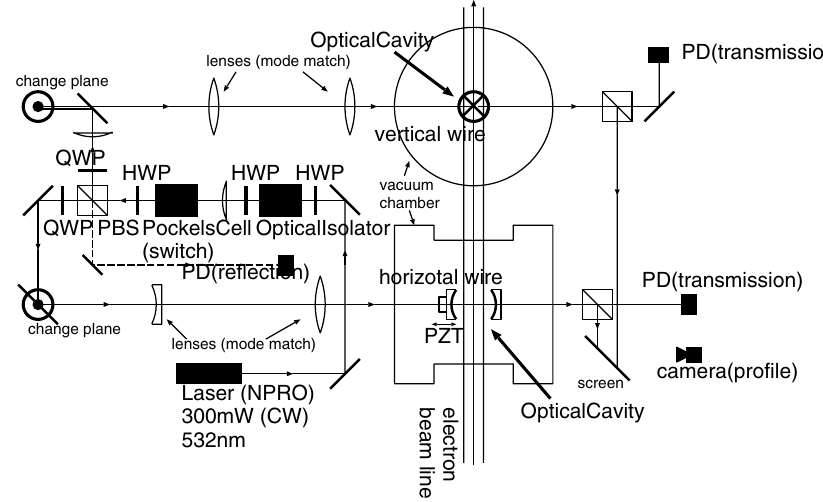
FIG. 2. Schematic layout of the laser wire setup. The symbols stand for p - i - n photodiodes (PD), half-wave plate (HWP), quarter- wave plate (QWP), polarizing beam splitter (PBS), and piezoactuator (PZT).